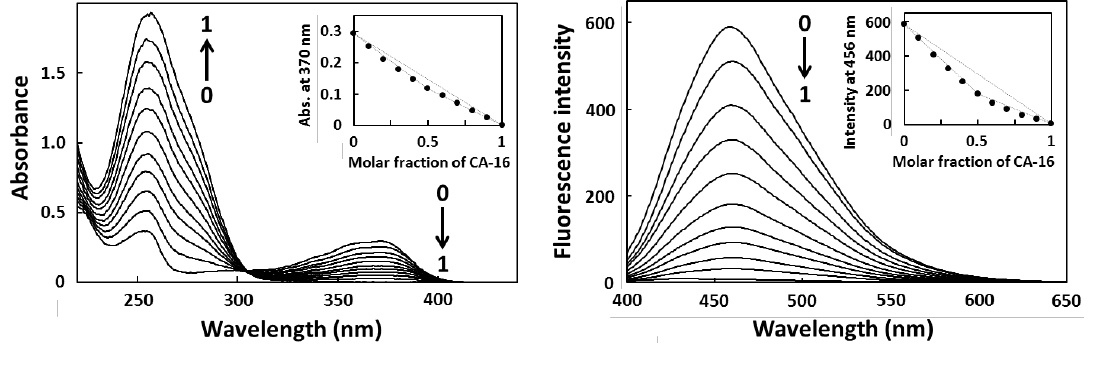
Figure 2. Continuous variation binding analysis (Job plot) of CPT1 using UV-vis spectroscopy (left) and fluorescence spectroscopy (right). Total concentration of CPT1 and CA-16 was maintained at 10 μM.